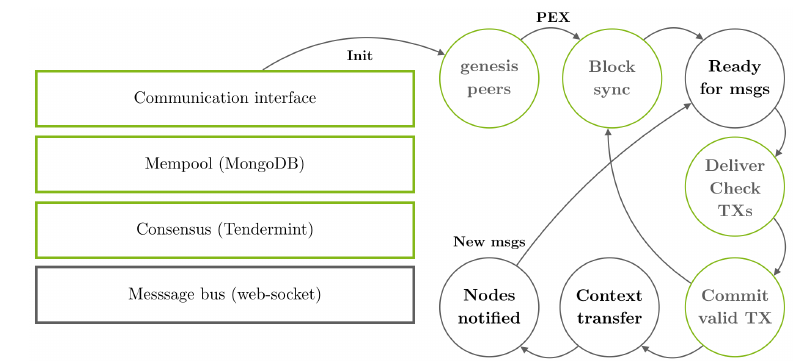
Fig. 2. State machine of the DezCom stack with messaging